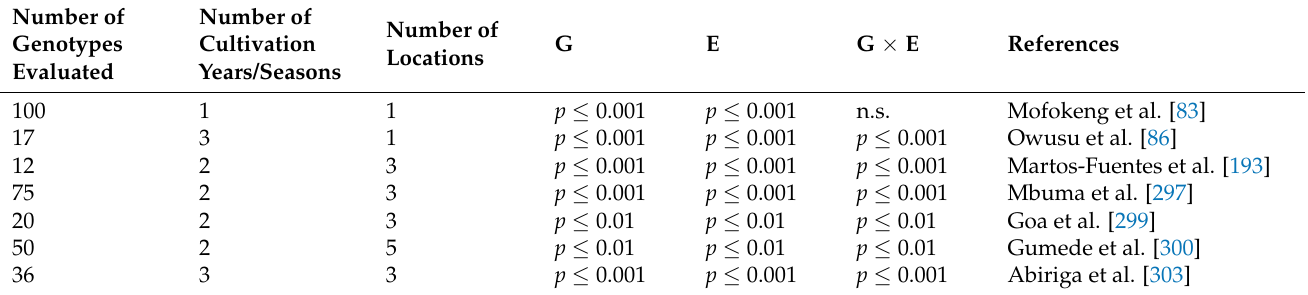
Table 6. Significance of genotypic effect (G), environmental effect (E) and genotype x environment interaction (G × E) while evaluating cowpea genetic